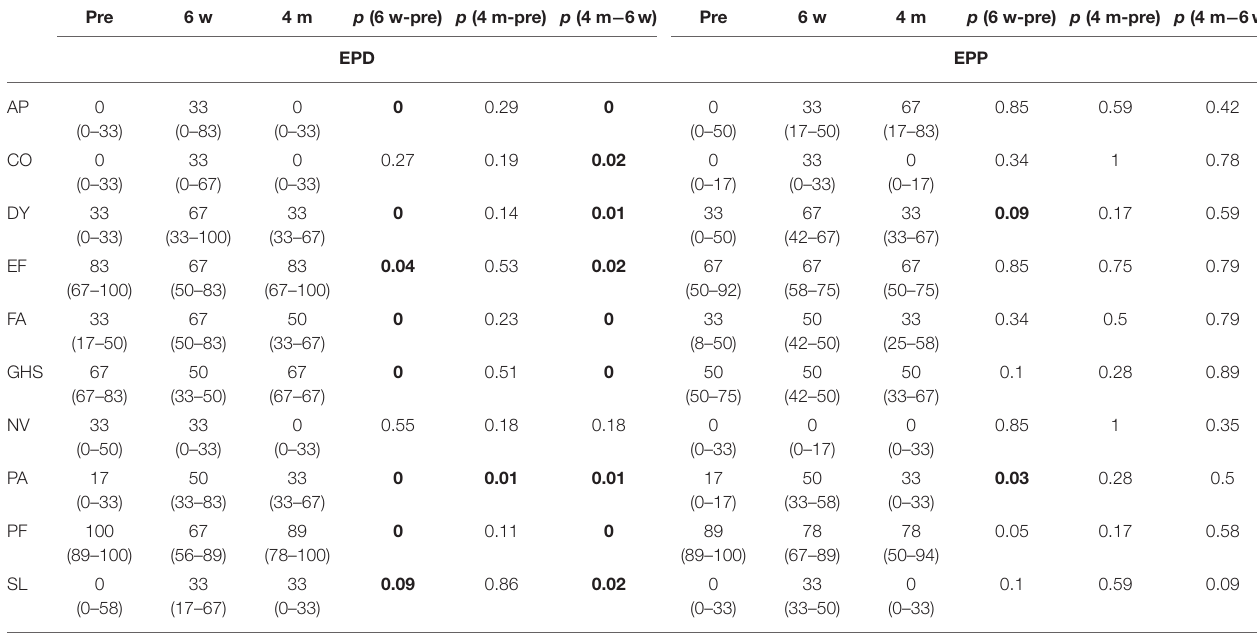
TABLE 3 | EORTC C15